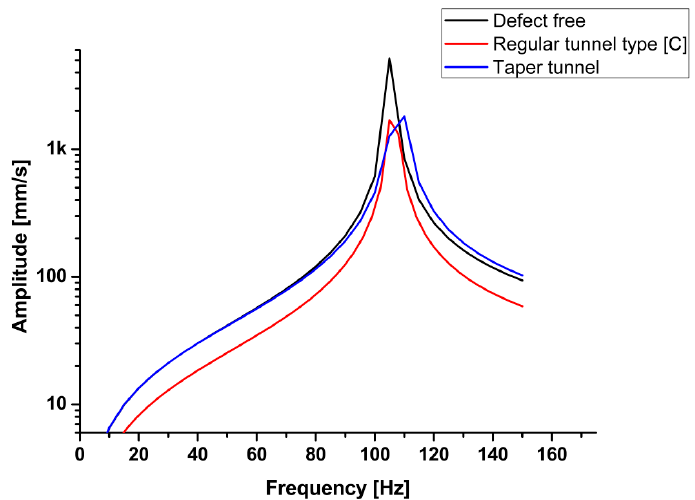
Figure 14. FRF simulation of large tunnel defects.